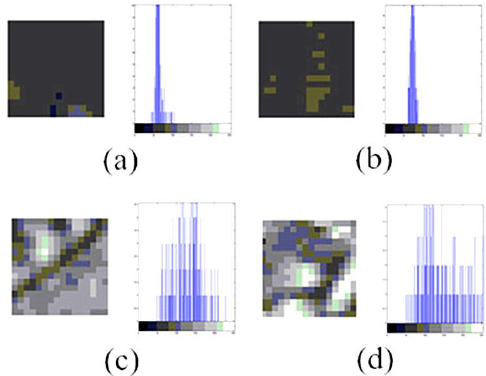
Figure 3. Local images and their gradient histograms in polar body and non-polar body image patches. ( a ) Image and gradient histogram around a non-polar body image patch; ( b ) Image and gradient histogram around a polar body image patch; ( c ) Image and gradient histogram in the center of a non-polar body image patch; ( d ) Image and gradient histogram in the center of a polar body image